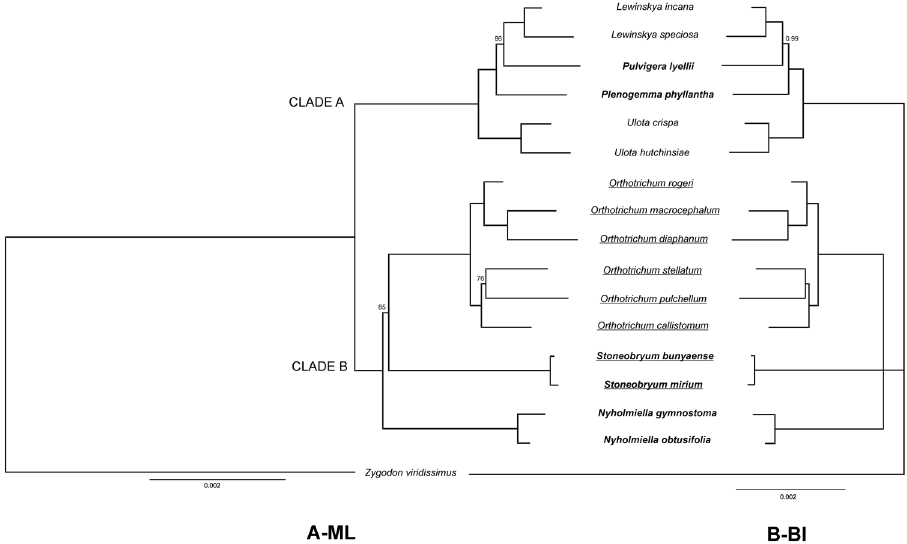
Figure 3. The phylogenetic relationships of 17 Orthotrichaceae species based on complete mitogenome sequences: A - Maximum Likelihood (ML), B - Bayesian Interference (BI). The bootstrap values (ML) and posterior probabilities for BI trees lower than the maximum values (100 and 1.0, respectively) are shown at the nodes. The underlined species have cryptoporous stomata, and taxa in bold are